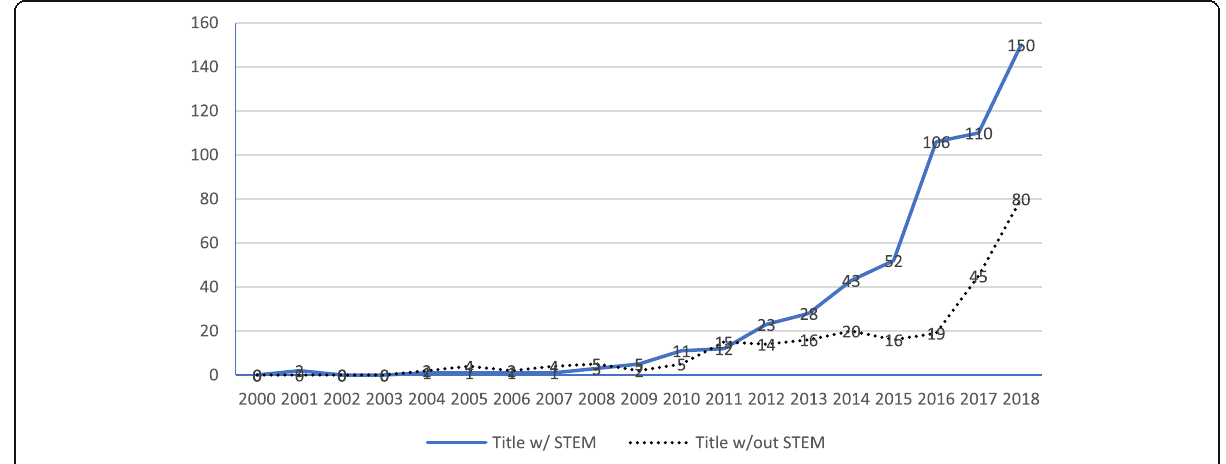
Fig. 2 The trends of STEM education publications with vs. without STEM included in the